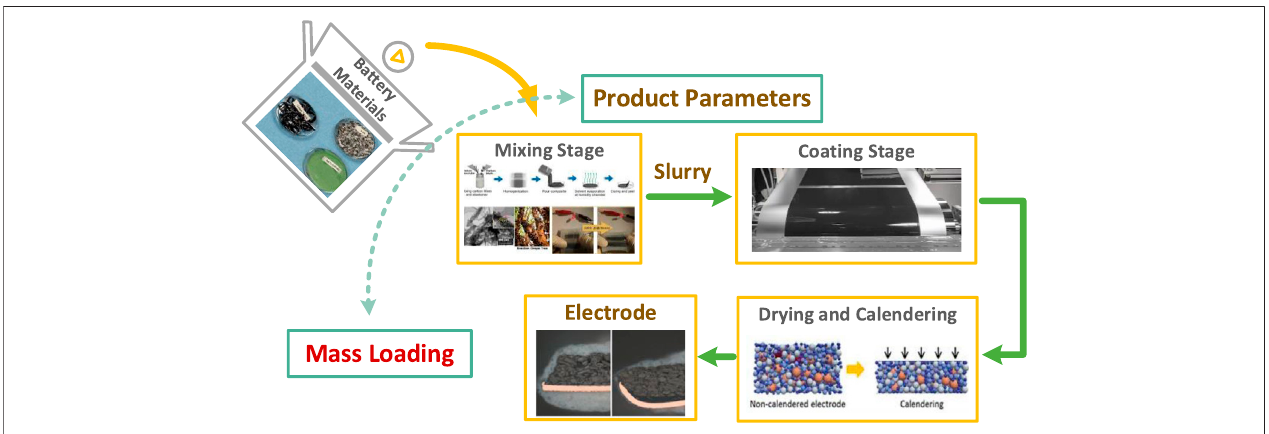
FIGURE 1 | Key early stages during the battery electrode manufacturing